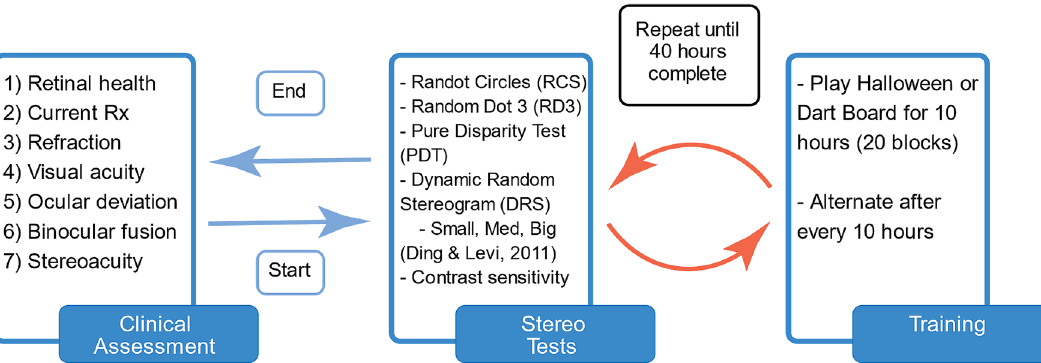
Figure 9. Study and training schematic. Each participant began with a clinical assessment. Followed by clinical and psychophysical stereoacuity tests. Participants then alternated between playing one of two games (Halloween or DartBoard) for 10 h. After every 10 h (20 blocks), clinical and psychophysical stereoacuity tests where administered until 40 h were completed. Lastly, the clinical assessment was